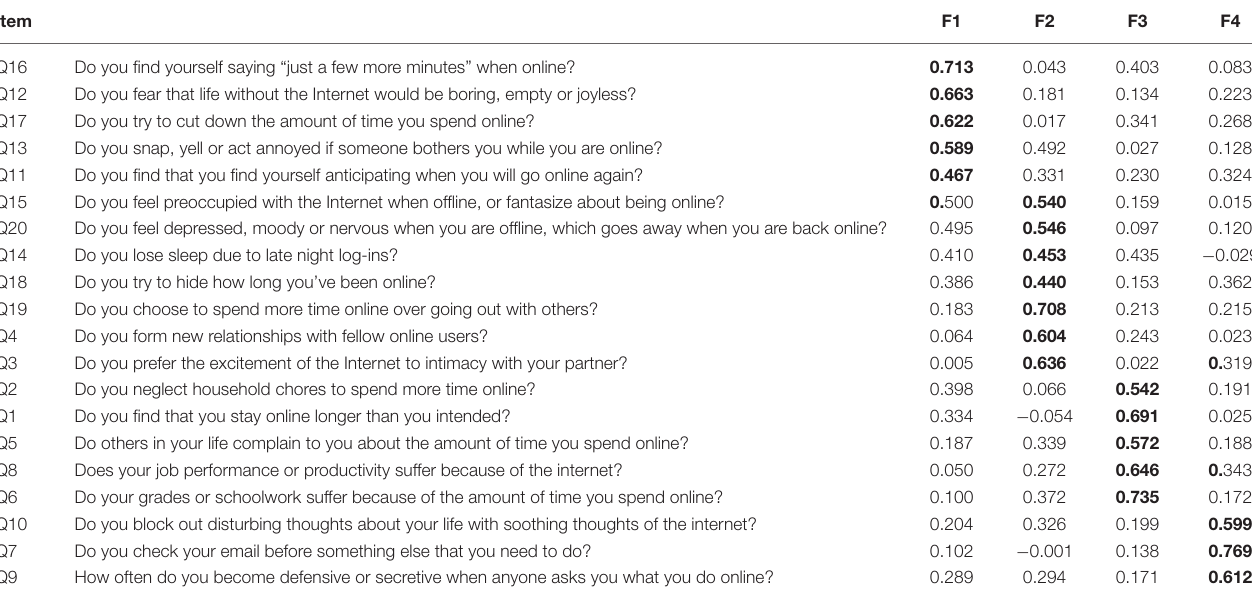
TABLE 1 | Factor loading resulted from EFA analysis.